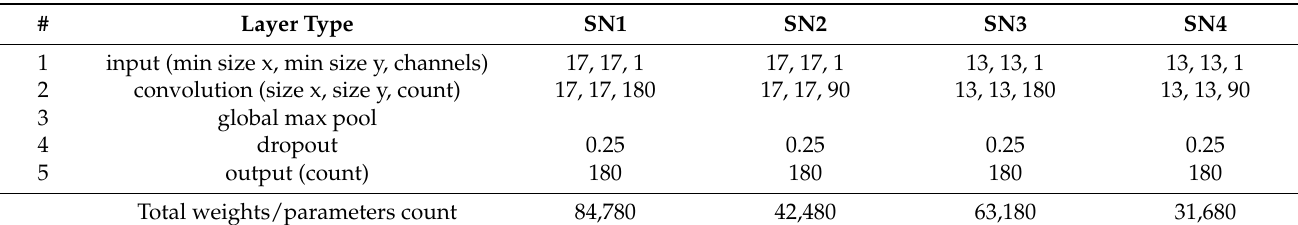
Table 1. The four shallow CNN architectures.